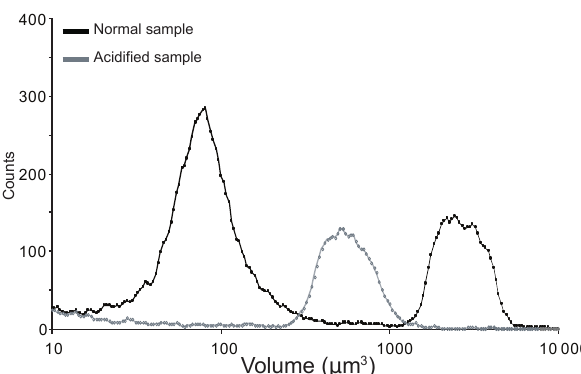
Figure 1. Example of Multisizer volume spectra. Black line: spec- tra of C. pelagicus population (coccolith spectrum and coccosphere spectrum); gray line: C. pelagicus coccolith-free cell after treatment with